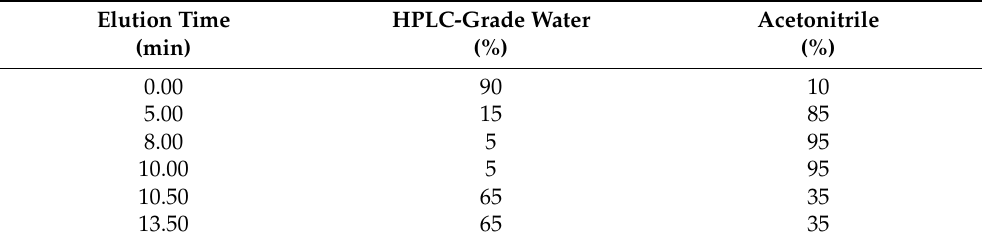
Table 1. Gradient elution procedures of